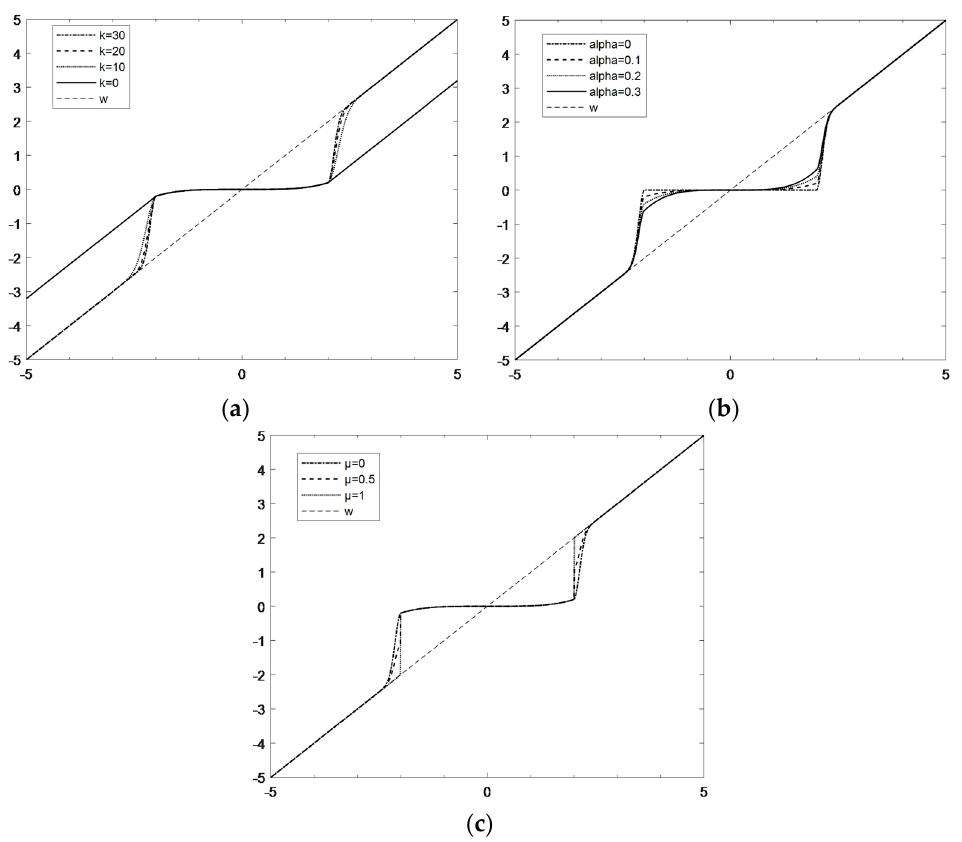
Figure 3. Comparison of the change curves of the three parameters in the improved threshold function: ( a ) when α and µ are fixed, k changes; ( b ) when k and µ are fixed, α changes; ( c ) when k and α are fixed, µ changes.